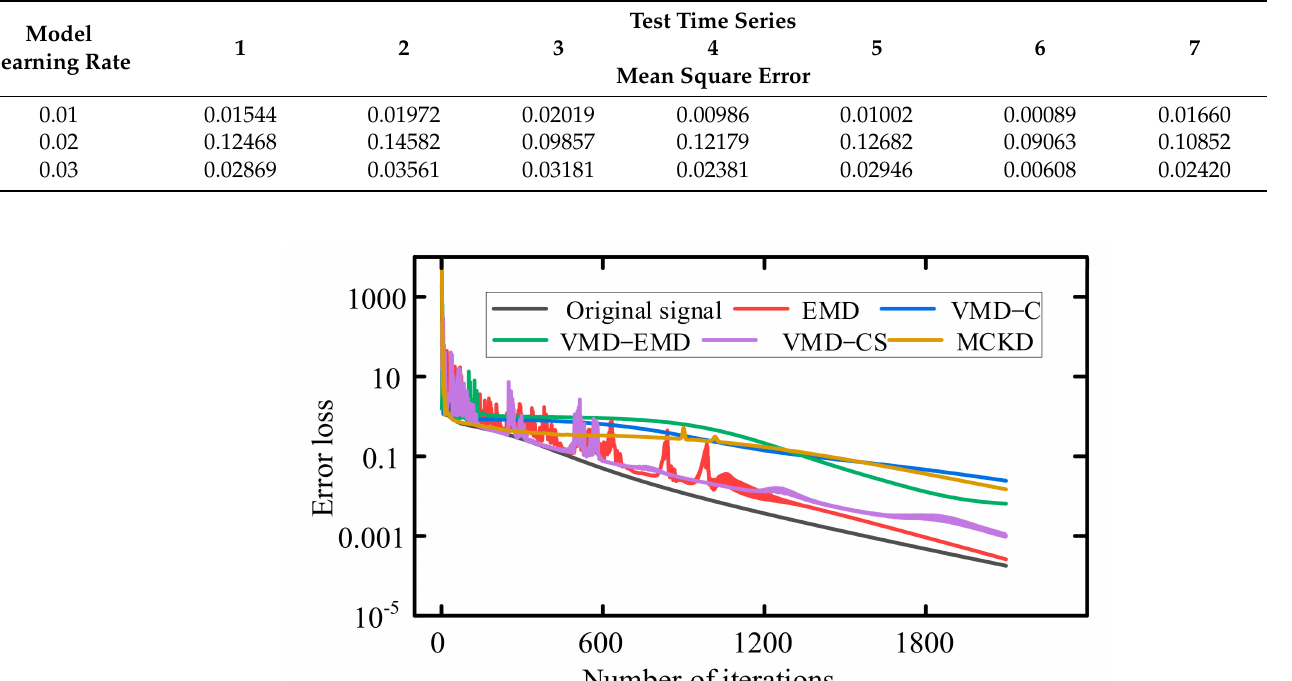
Table 3. The central frequencies of IMF components corresponding to different K values.